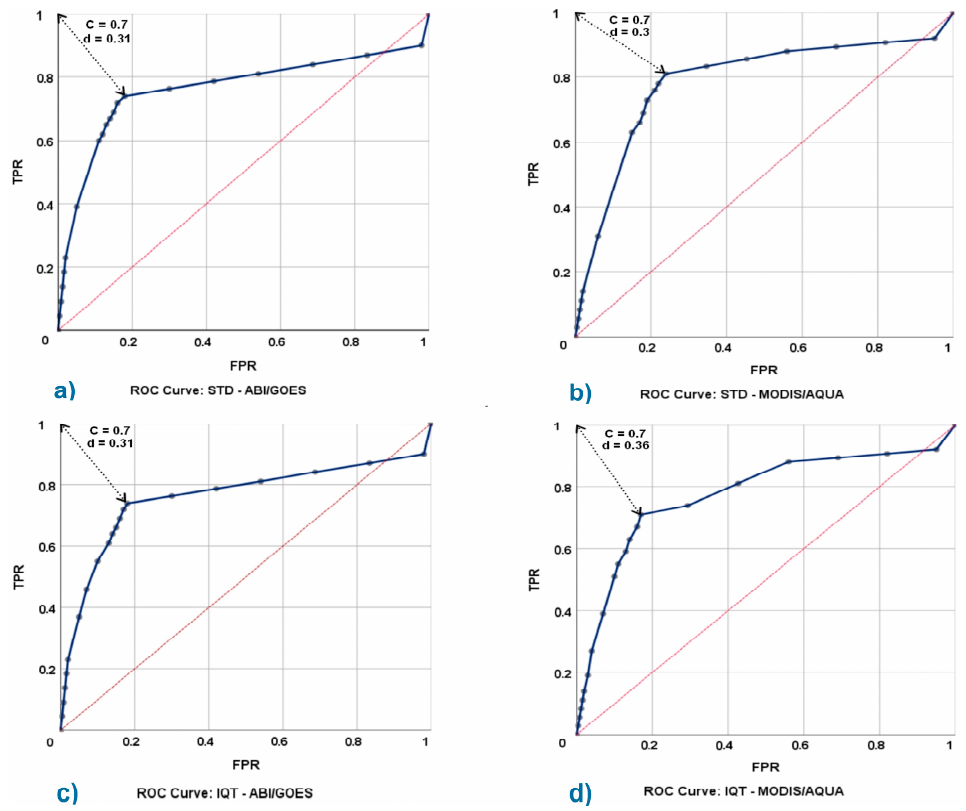
Figure 7. ROC curves of ( a ) STD-ABI/GOES, ( b ) STD-MODIS/AQUA, ( c ) IQT-ABI/GOES, and ( d )